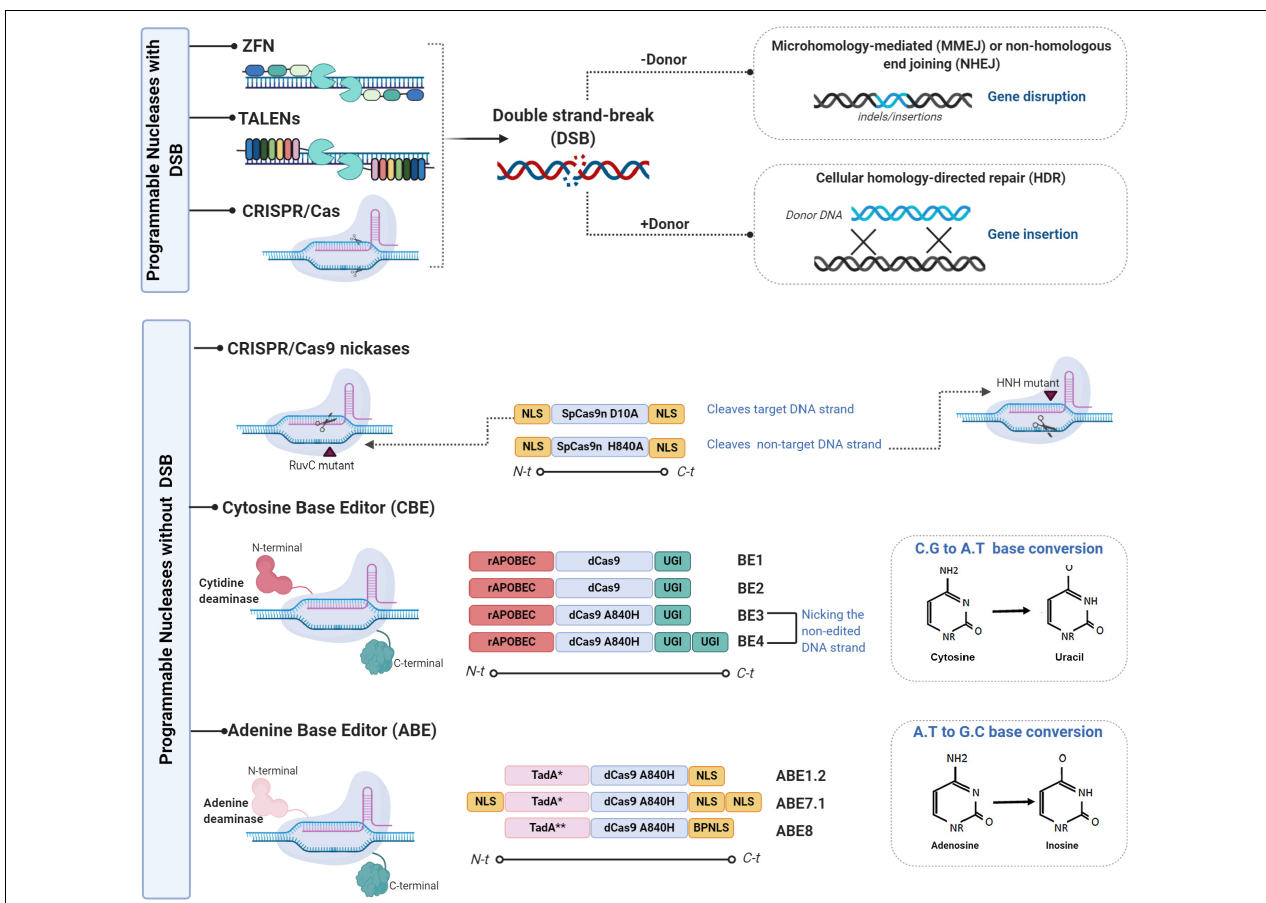
FIGURE 1 | Representative scheme of the different genome editing tools used to improve the immune system. There are two variants of genome editing technologies: those that introduce double-stranded breaks (DSBs) into DNA and those that enable genome editing without DSBs. The first variant is mainly composed of the components ZFNs, TALEN, and CRISPR/CAS which are used to enhance immune system capacity. ZFNs are chimeric proteins containing a DNA binding domain (3–5 zinc-finger domains) and a Fok1 endonuclease domain (114). Each zinc-finger domain is specifically designed to bind to virtually any DNA sequence. ZFN cleavage activity needs to be dimerized given that Fok1 acts as a dimer. Two ZFNs therefore need to be designed, each targeting a DNA sequence separated by a short sequence from the recognition site of the other ZFNs in a head-to-head fashion. As ZFNs, TALENs contain two different domains: the DNA binding domain of the TALE protein designed to bind the desired sequence (10) and the Fok1 endonuclease domain (11). As TALENs only act as dimers, two TALENs must be designed to bind to the target locus in a face-to-face fashion to cleave the target sequence (110). CRISPR/Cas, the last described SENs, is the easiest to design and the most versatile gene editing tool. It is derived from the adaptive immune system of prokaryotes, which provides a defense mechanism against certain viral infections and plasmids. The CRISPR/Cas protein forms a complex with the RNA molecules crRNA (CRISPR RNA) and crRNA (tracrRNA) which guides the Cas protein to the target DNA and produces the cleavage (12). The only part that needs to be changed to specifically cut a new target site in the genome is 20 crRNA nucleotides (13, 14). Various modifications to the gRNA design and to the Cas9 protein have been made to reduce off-target activity. A mutated Cas9 nickase has been generated to expand the CRISPR genome editing system (111). The second group is mainly composed of CRISPR-CAS nickases variants and of two base editor (BE) variants, the cytosine base editor (CBE) and the adenine base editor (ABE). The first variant is based on simple APOBEC deaminase system named BE1, which fuses APOBEC1 and dead Cas9 from Streptococcus pyogenes with D10A and H840A mutations (28). Its lower efficiency is attributable to uracil DNA glycosylase (UDG) which catalyzes the removal of U from DNA in cells and initiates base-excision repair (BER), thus converting the U:G pair to the C:G pair (115). The uracil-DNA glycosylase inhibitor (UGI) was fused to the C terminus of BE1 to create the second-generation BE2 system, with an improved base editing yield of 50%. A further improvement was implemented for the third-generation BE3 system. The improved BE4 base editor contains a rAPOBEC cas9 linker expanded to 32 amino acids, a Cas9n-UGI linker expanded to 9 amino acids, as well as the addition of a second copy of UGI to the C terminus of the constructs (116); BE3 and BE4 have been validated for use as base editors of human primary T cells (55). The replacement of the APOBEC1 component in BE3 with natural adenine deaminase Escherichia coli TedA led to the creation of the first adenine base editor ABE which was followed by ABE1.2 After several target mutations and optimizations, the ABE7.1 base editor was released. This was followed by the latest version ABE8 with its base editing facility particularly for HSPCs and human primary T cells (33). Figures were created by